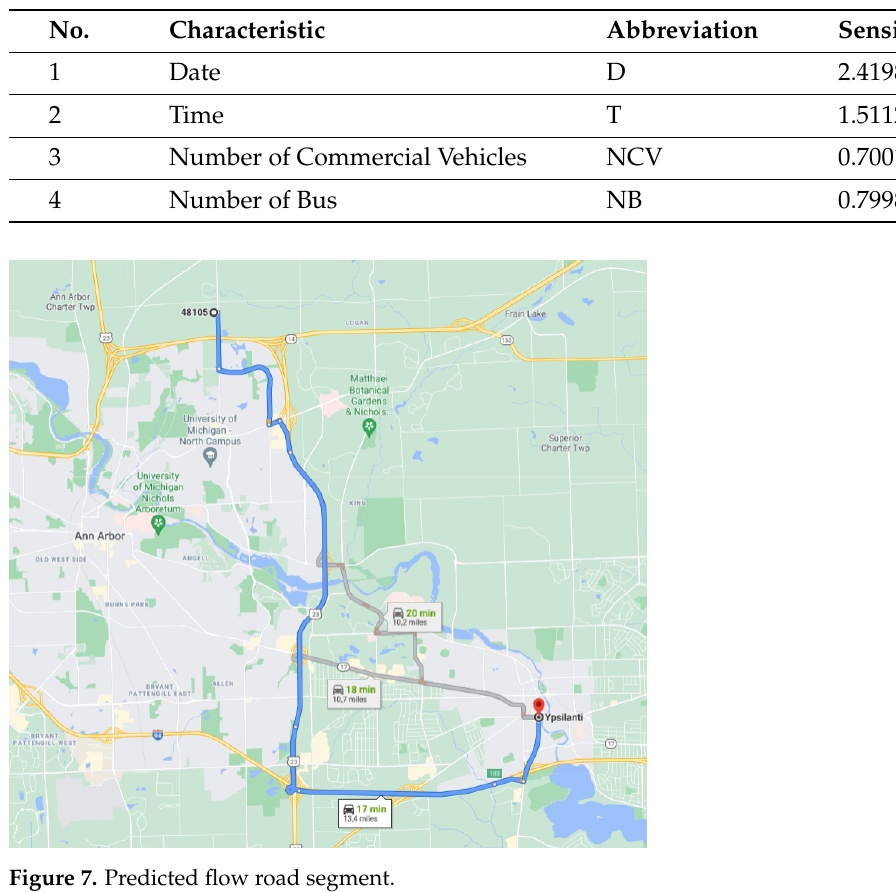
Table 6. Input layer parameters.